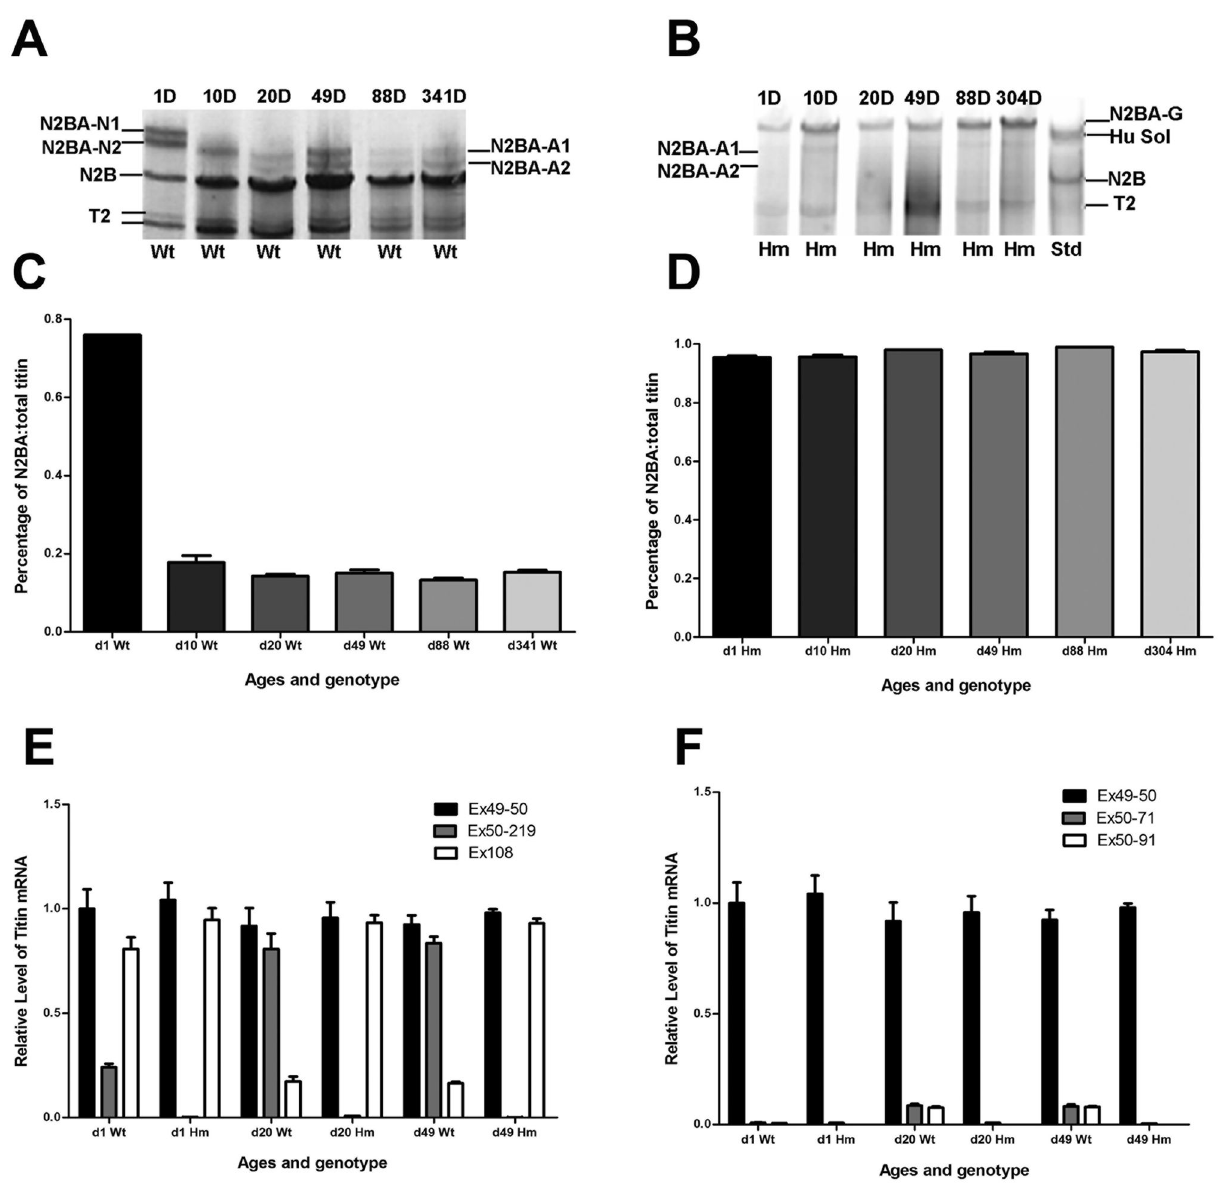
Figure 1. Developmental changes in expression of titin protein isoforms and mRNA in wild type (Wt) and homozygote (Hm) mutants. Proteins were separated by SDS agarose electrophoresis [16]. D: days after birth; Std: mixture of human soleus (3.7 MDa) & rat N2B (3.0 MDa); T2, titin fragment; Ex, exon. A. Larger N2BA isoforms (3.6 to 3.7 MDa) were present at one day after birth and disappeared with age in normal rats during development. B. A different larger N2BA isoform (3.8 MDa) appeared in mutant homozygote rats; the smaller N2B and other shorter N2BA isoforms were essentially absent at all ages. C. The smaller N2B isoform increased in proportion with age and reached approximately 85% (P<0.01) from 20 days of age and older in wild type. D. The larger N2BA isoform in homozygous mutants constituted nearly 100% (P<0.05) of the total titin. E. Relative titin mRNA expression in wild type and mutant rats determined by Q-PCR. All data are from an average of triplicates (P<0.05). Primers for exons 49 to 50 would prime both N2B and N2BA titin isoforms; primers for exons 50 and 219 would amplify the N2B only, and primers for exon 108 would amplify the N2BA isoforms only. F. Relative mRNA expression of other pre-identified titin isoforms to total titin in wild type and mutant rats. Total titin of 1 day Wt was defined as 1.0 for all the comparisons.